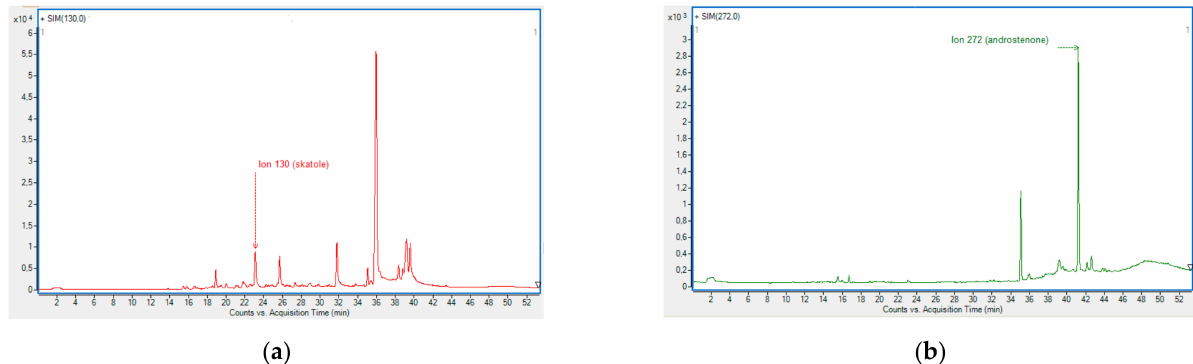
Figure 3. Detection of ions in selection ion monitoring mode (SIM mode) for samples incubated at 150 ◦ C. Quantitative ions for semi-quantification of ( a ) skatole ( m/z 130, peak at Rt = 23.096 min) and ( b ) androstenone ( m/z 272, peak at Rt = 41.233